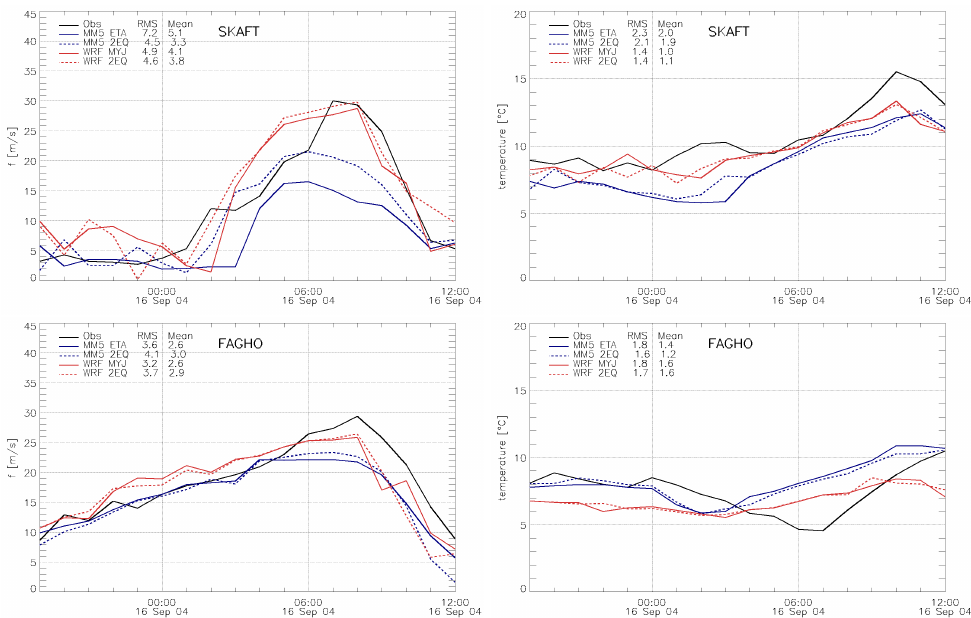
Figure 5: Observed (solid black) and simulated (solid blue – MM5/ETA, blue dash – MM5/2EQ, solid red – WRF/MYJ, red dash – WRF/2EQ) 10 metre wind speed [ms − 1 ] (left) and 2-metre temperature [ ◦ C] (right) at station SKAFT (WMO# 4172, top row) in the lee of Mt. Öræfajökull and at station FAGHO (bottom row).